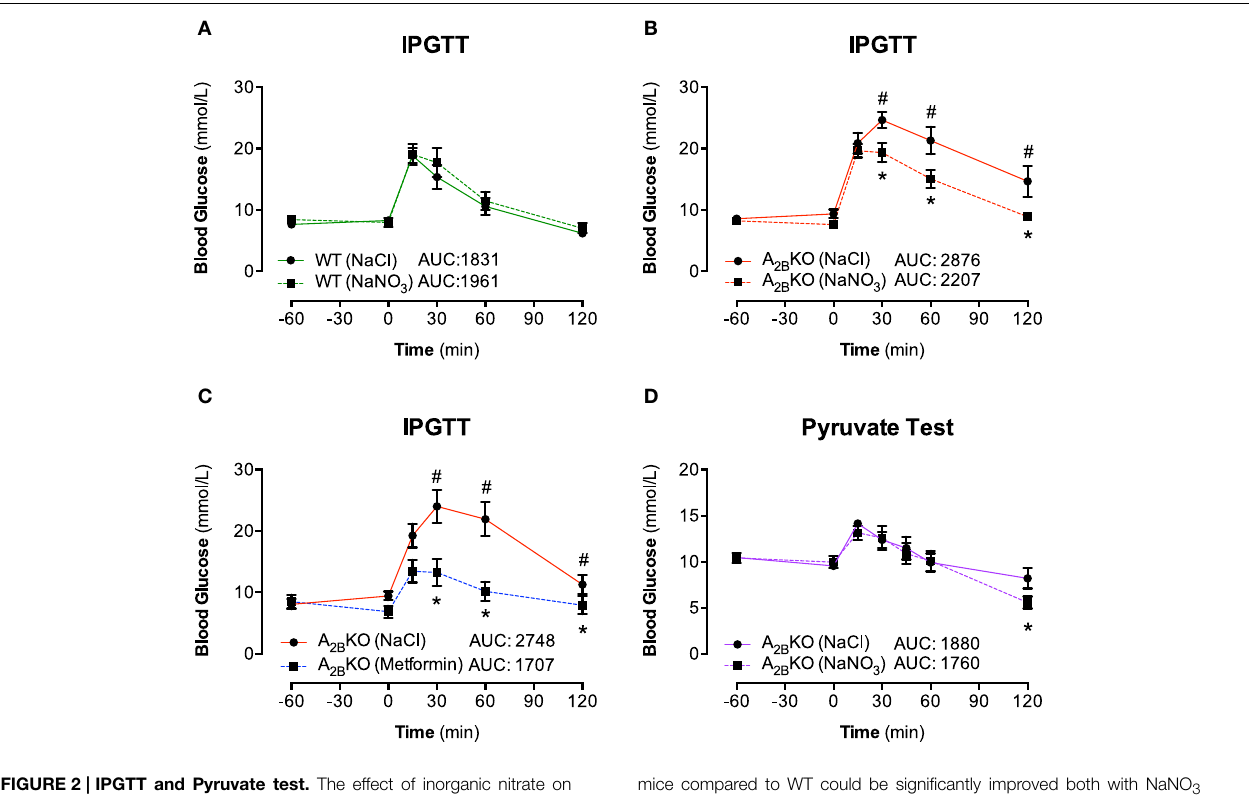
FIGURE 2 | IPGTT and Pyruvate test. The effect of inorganic nitrate on glucose tolerance was determined by measuring plasma glucose levels in WT mice (A) and A 2B KO mice (B) after placebo (NaCl) or nitrate injection